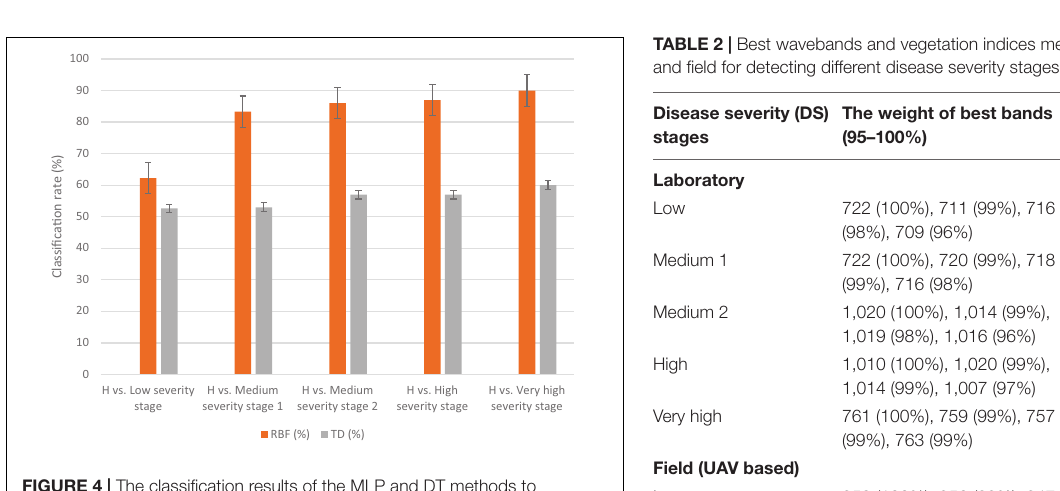
FIGURE 4 | The classification results of the MLP and DT methods to distinguish healthy (H) against several disease severity stages of downy mildew disease in watermelon in the laboratory. The vertical lines on the columns are error bars.